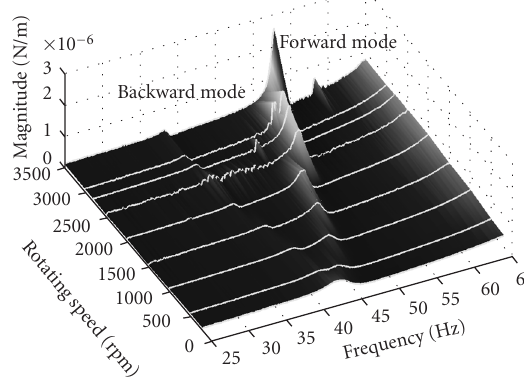
Figure 14: The waterfall function for the configuration C